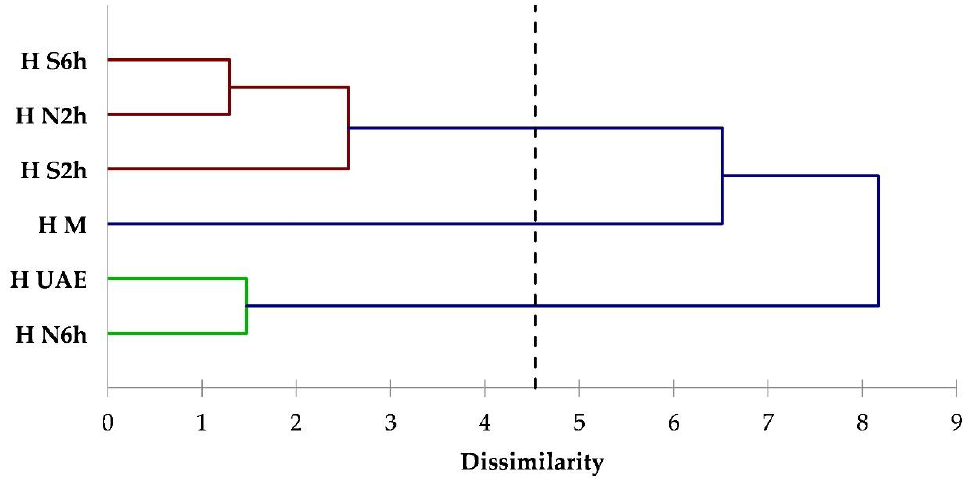
Figure 3. Dendrogram obtained from the cluster analysis based on terpenes classes data for hemp extracts.